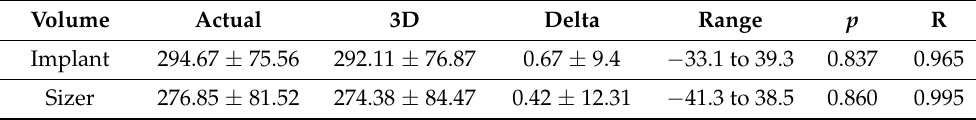
Table 2. Comparison of digital volume change and implant/sizer